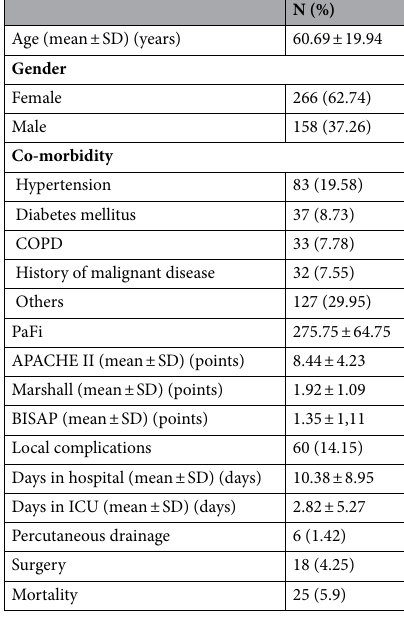
Table 2. Demographic and clinical characteristics.